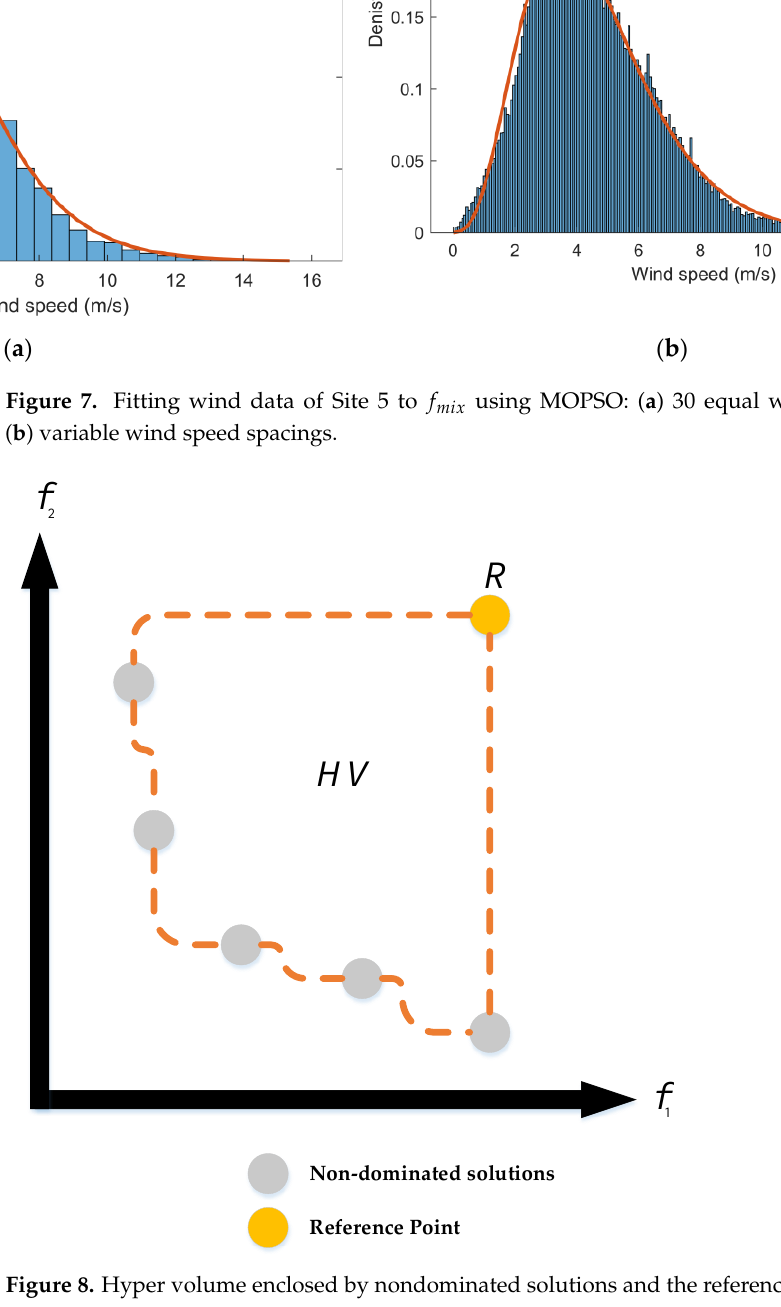
Table 10. Comparison between NSGA-II and MOPSO using the hyper volume index. Case